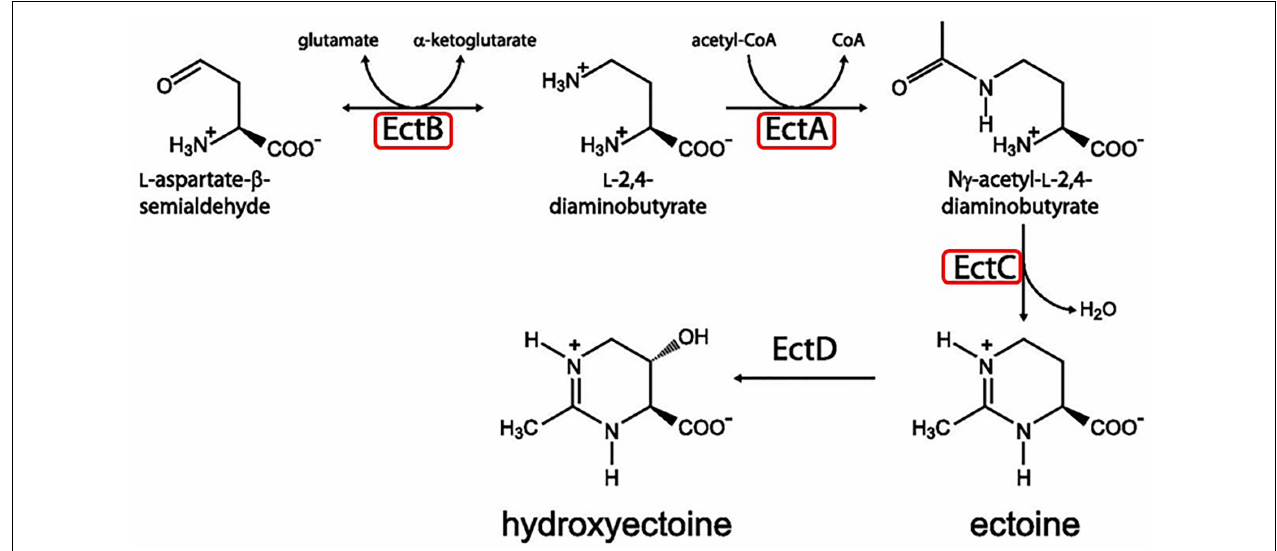
FIGURE 5 | The ectoine biosynthesis pathway. Acidihalobacter genomes contain the genes ectABC (highlighted in red boxes) but not ectD and therefore are likely to synthesize ectoine but not hydroxyectoine through the pathway shown. Reproduced from Ofer et al. (2012) with permission from American Society for